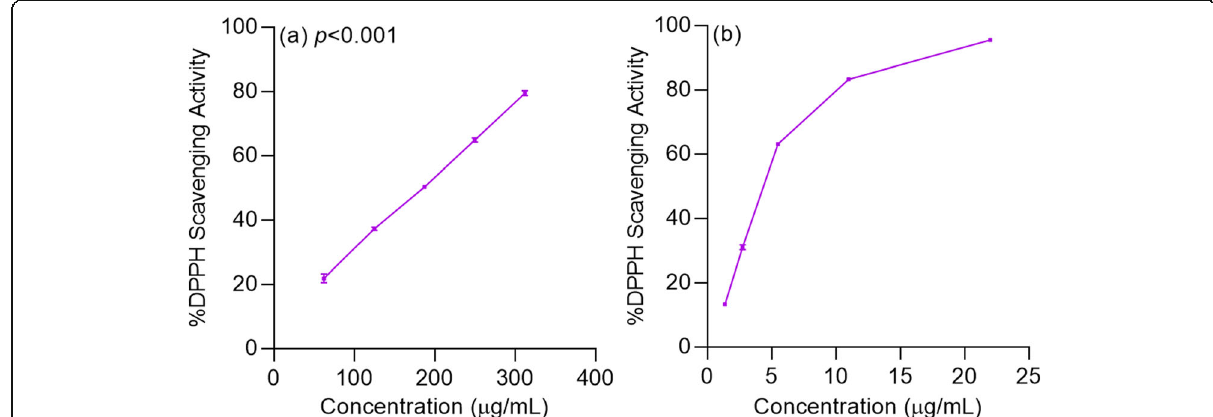
Fig. 1 DPPH scavenging activity of AP-XS extract ( a ) and vitamin C ( b ). p < 0.001, a significant difference one by one in each test (t-test). All values are reported as means ± SEM ( n = 3)